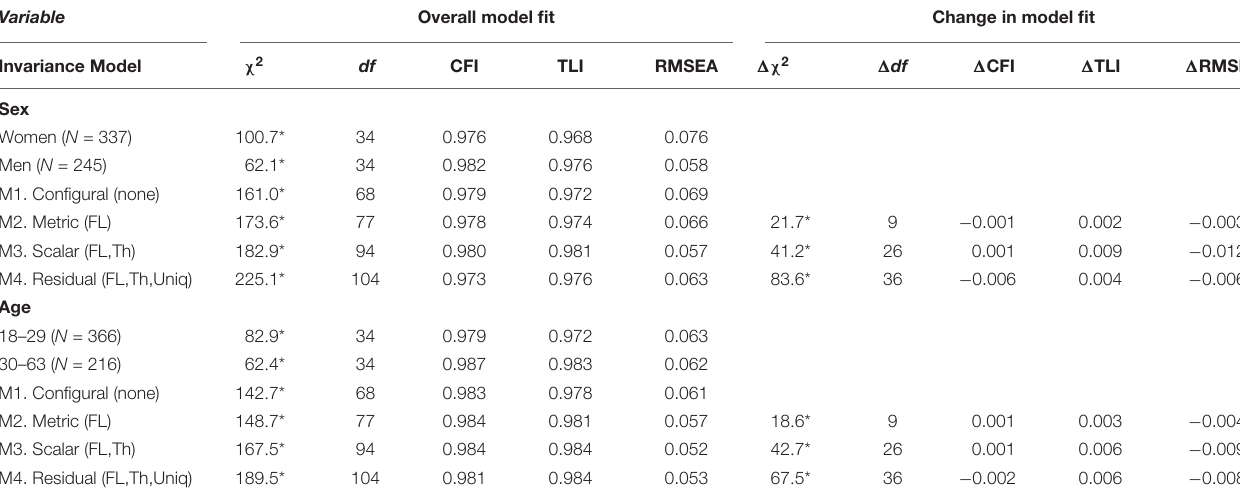
TABLE 4 | Factorial invariance of the RSES for the screened sample with the Arias et al. method ( N = 582). Variable Overall model